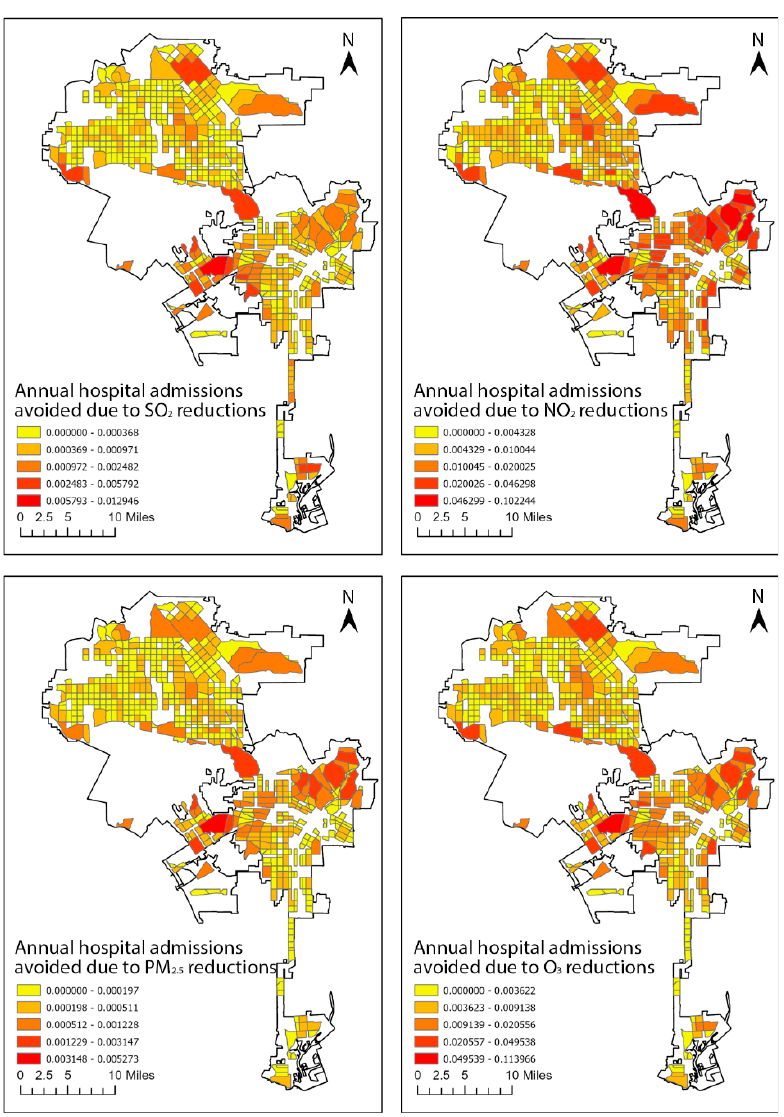
Figure 4. Annual hospital admissions avoided due to air pollutant reductions estimated by BenMap-CE.